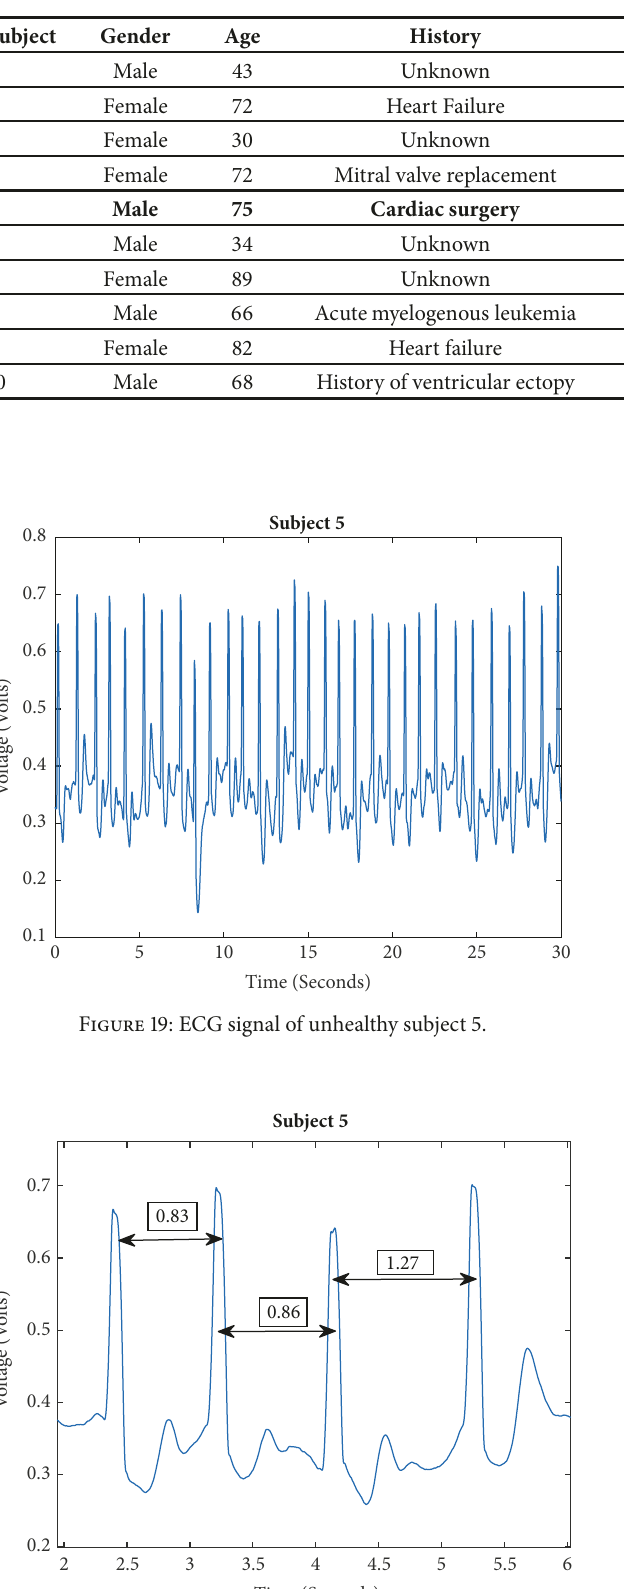
Table 7: Information of unhealthy test subjects.